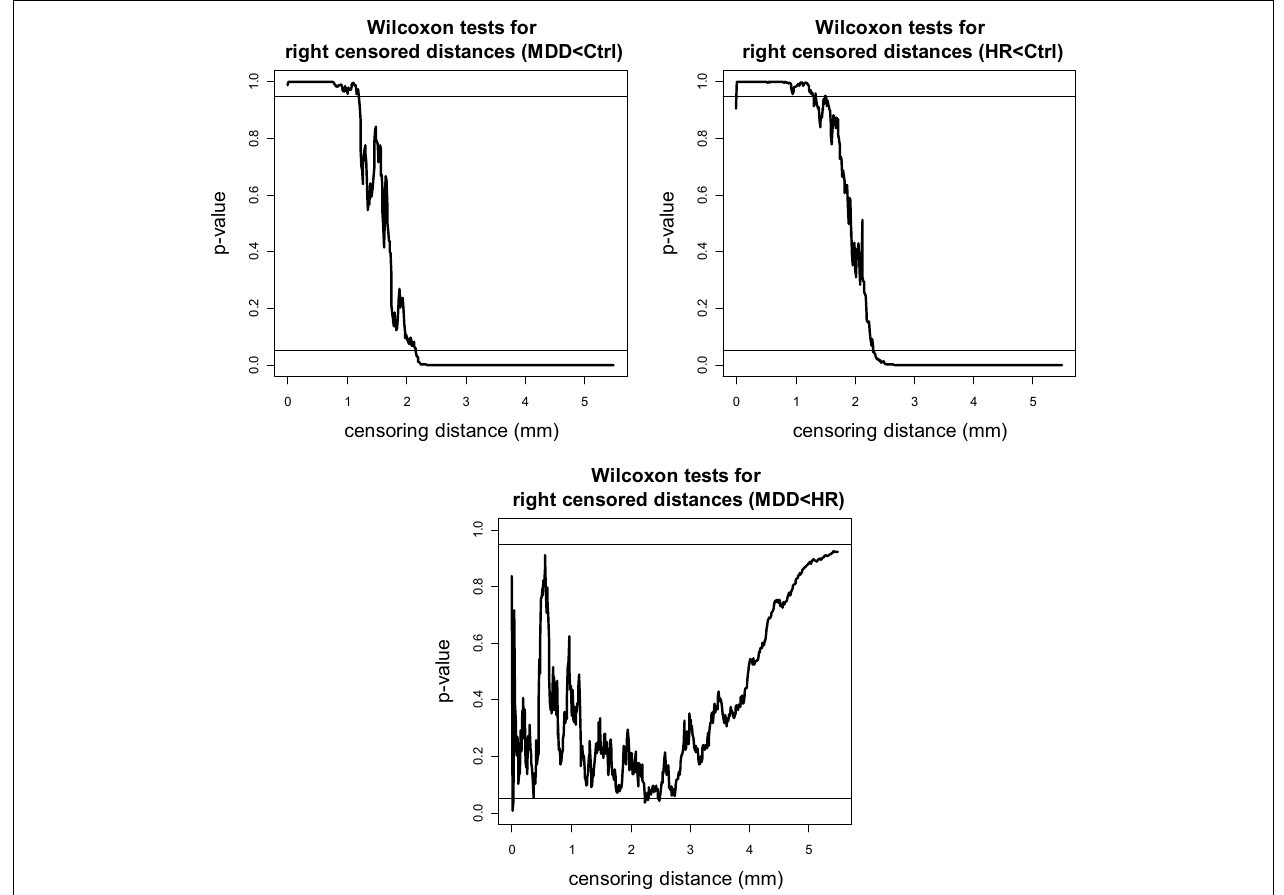
FIGURE 5 |The p -values versus censoring distance values (millimeter) for pairwise comparisons of rightVMPFC distances withWilcoxon rank sum test for the less than alternative . Horizontal lines and alternatives are as in Figure 4 .